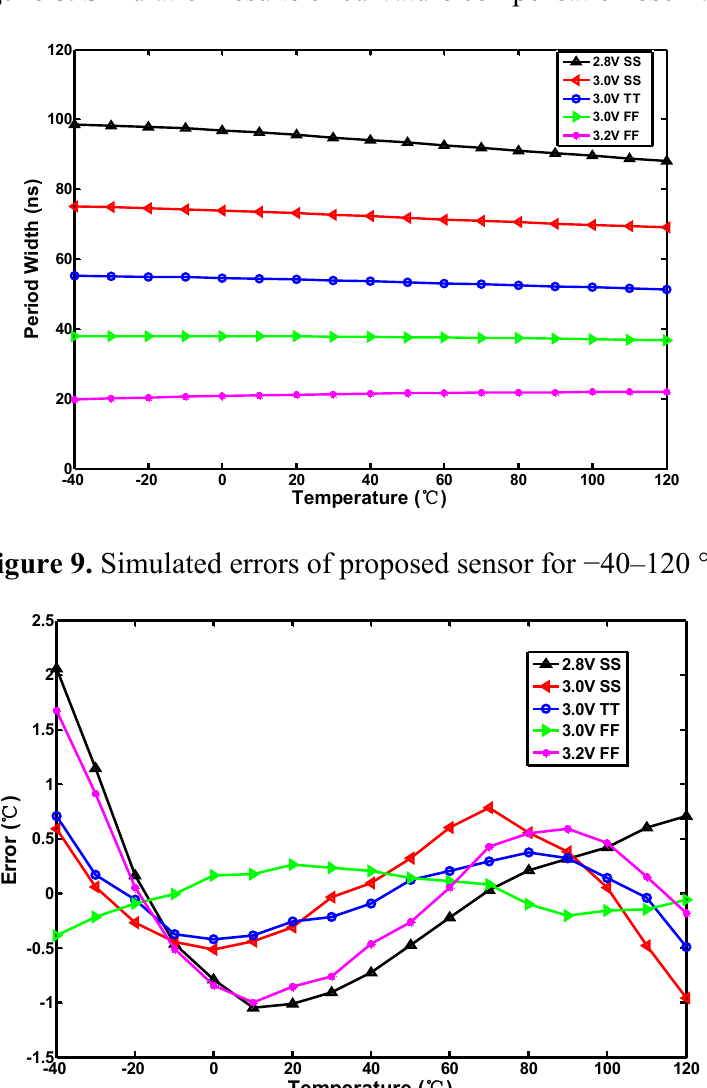
Figure 8. Simulation results of curvature compensation oscillator.